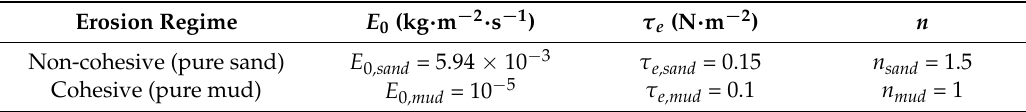
Table 2. Erosion parameters for pure sand and pure mud sediment.